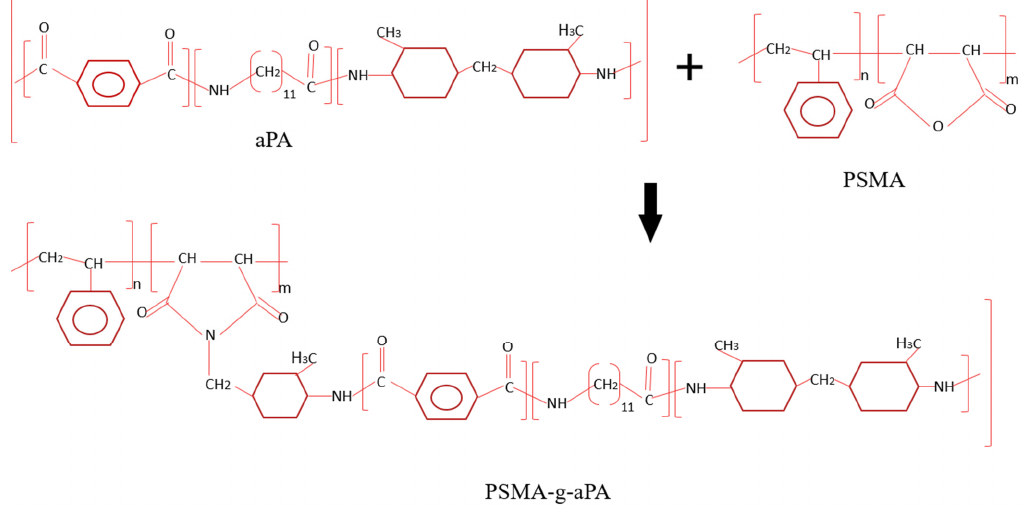
Figure 2. Chemical reaction between amine groups in aPA and malaeic anhydride groups in PSMA.